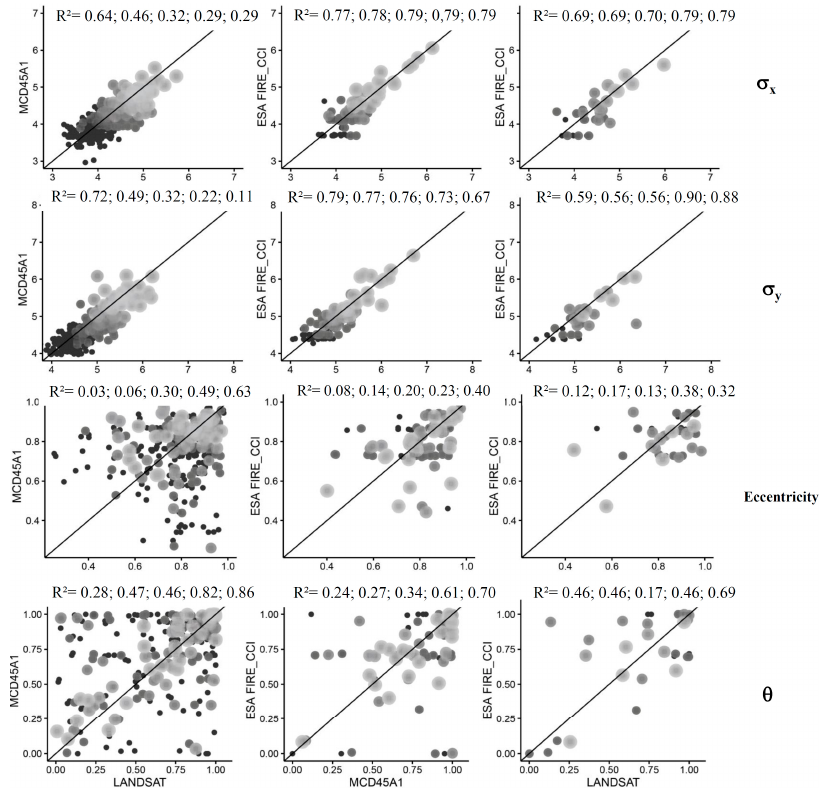
Figure A3. Correlations of the ellipse metrics, fitted over fire patches (shortest and longest axis σ x and σ y (log transformed), eccentricity and azimuthal angle of the longest axis theta) for comparison: 1—LANDSAT × MCD45A1, 2— MCD45A1 × ESA FIRE_CCI and 3 — LANDSAT × ESA FIRE_CCI. The grey scale color of individual points correspond to their patch size class from 90 ha (black), 270 ha, 450 ha, 630 ha, to 900 ha (light grey). R 2 values indicate the coefficient of determination of the regressions, ordered according to the patch size classes.